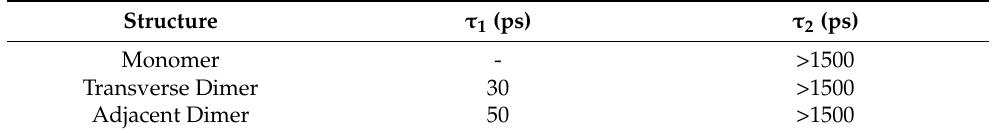
Table 3. Time Constants Derived from a Global Target Analysis of Femtosecond Visible Transient Absorption of DNA-Templated Perylene Monomer, Transverse Dimer, and Adjacent Dimer